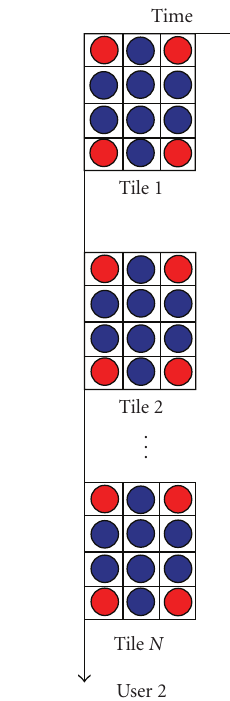
Figure 8: Subchannelization procedure for bidirectional commu- nication using the IEEE 802.16e protocol. In uplink, each user is allocated K slots spanning N f subchannels in frequency over N t slot-durations. Each slot-duration comprises 3 consecutive OFDM symbols, whereas each subchannel contains 6 tiles distributed throughout of the useful frequency band. A tile contains 4 subcarries over a slot-duration with the 4 pilots at the corners of the tile and the remaining 8 tones used for data. In the above figure, there are N tiles with N t = 1, N f = N/ 6, and K = N t N f = N/ 6. The circles filled with violet and red colors indicate the pilot tones of users 1 and 2, respectively, whereas the circles filled with black and blue colors indicate the data tones of users 1 and 2, respectively.